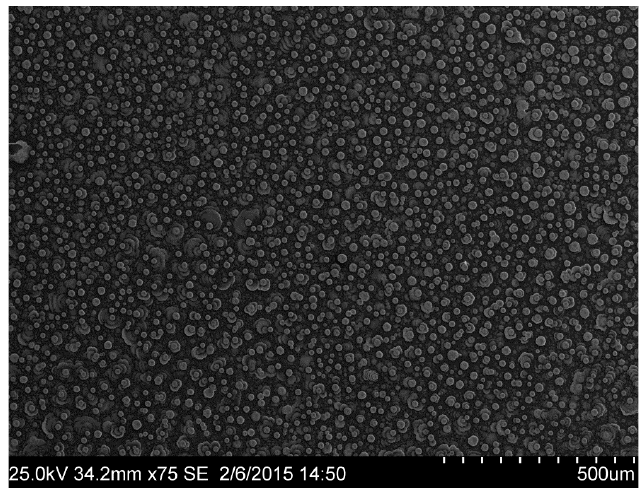
Figure 11. Scanning Electron Microscopy (SEM) image of an 800 thick MAPI thin layer deposited by spin-coating on a quartz substrate.